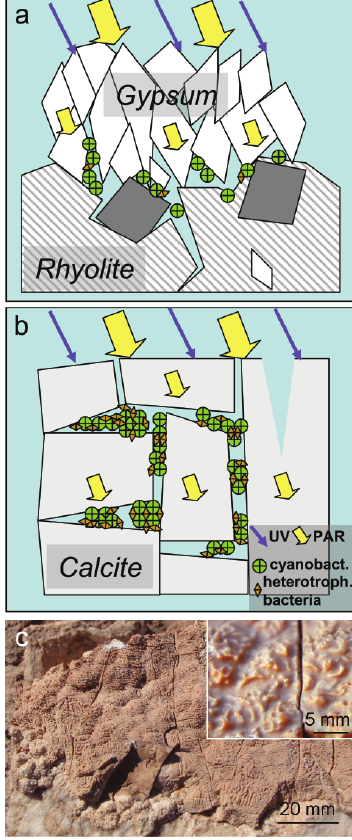
Fig. 3. Scheme illustrating the physical properties of the Tilo and Luna rock substrates and the topology of the chasmoendolithic colonisation. (a) In rocks from the Tilocalar area, the microorgan- isms are localised between the gypsum deposits and rhyolite rock, up to 5mm deep, affording little space for water retention. (b) The network of crack and fissures, up to 30mm deep, of calcite rocks from Valle de la Luna provide ample space of colonisation and water retention. Both rock substrates protect microorganisms from the deleterious effect of UV radiation while allowing enough PAR through for photosynthetic activity. Drawings are on different scales. (c) Surface of calcite bed from Valle de la Luna showing microrill (rillensteine) weathering features. Insert image shows a detailed view of these calcite dissolution structures; note the irreg- ularly fractured limestone hardened